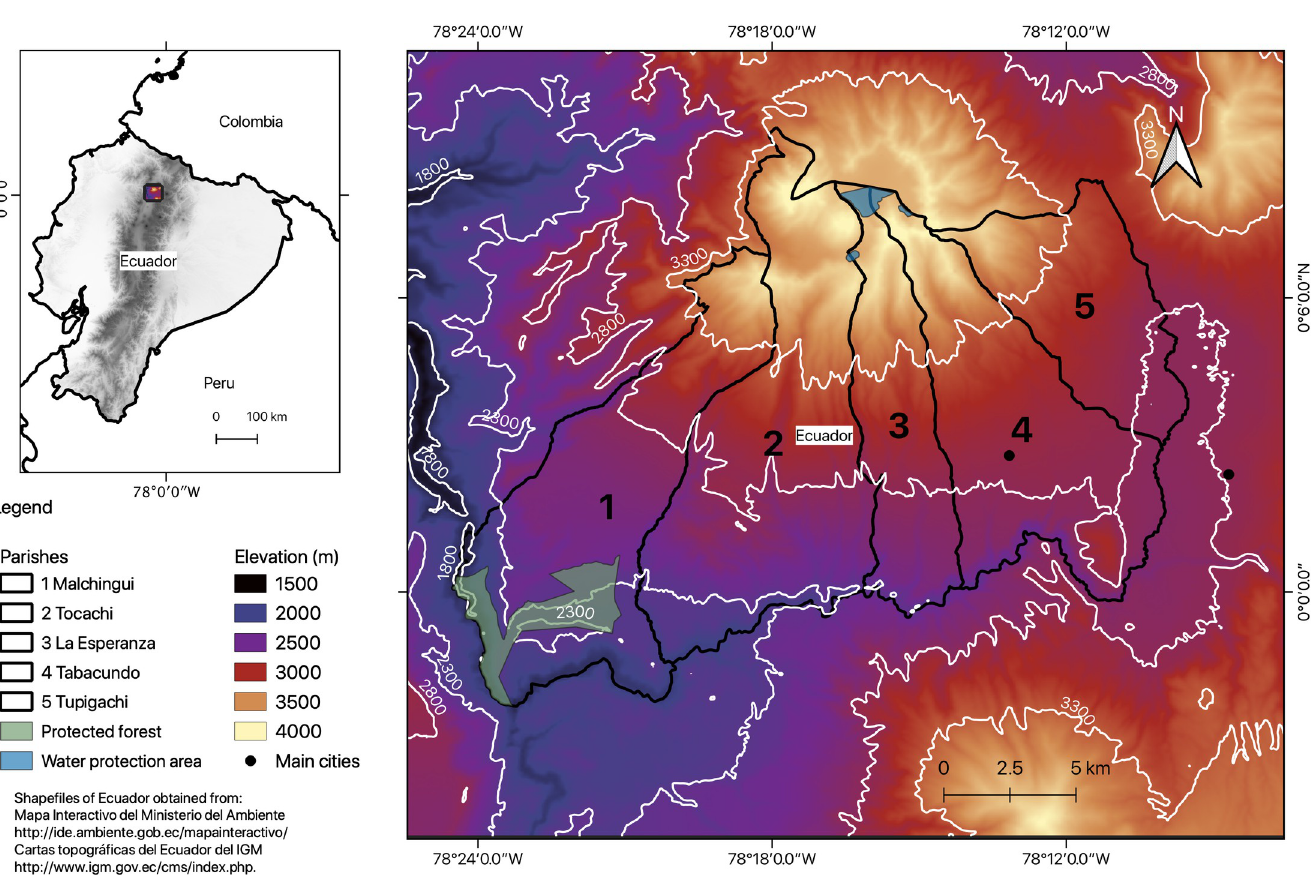
Fig 2. Study area of the Pedro Moncayo county in the highlands of northern Ecuador. (Data sources: ASTER Global Digital Elevation Model courtesy of NASA Earth Data. Made with Natural Earth. Free vector and raster map data @ naturalearthdata.com).